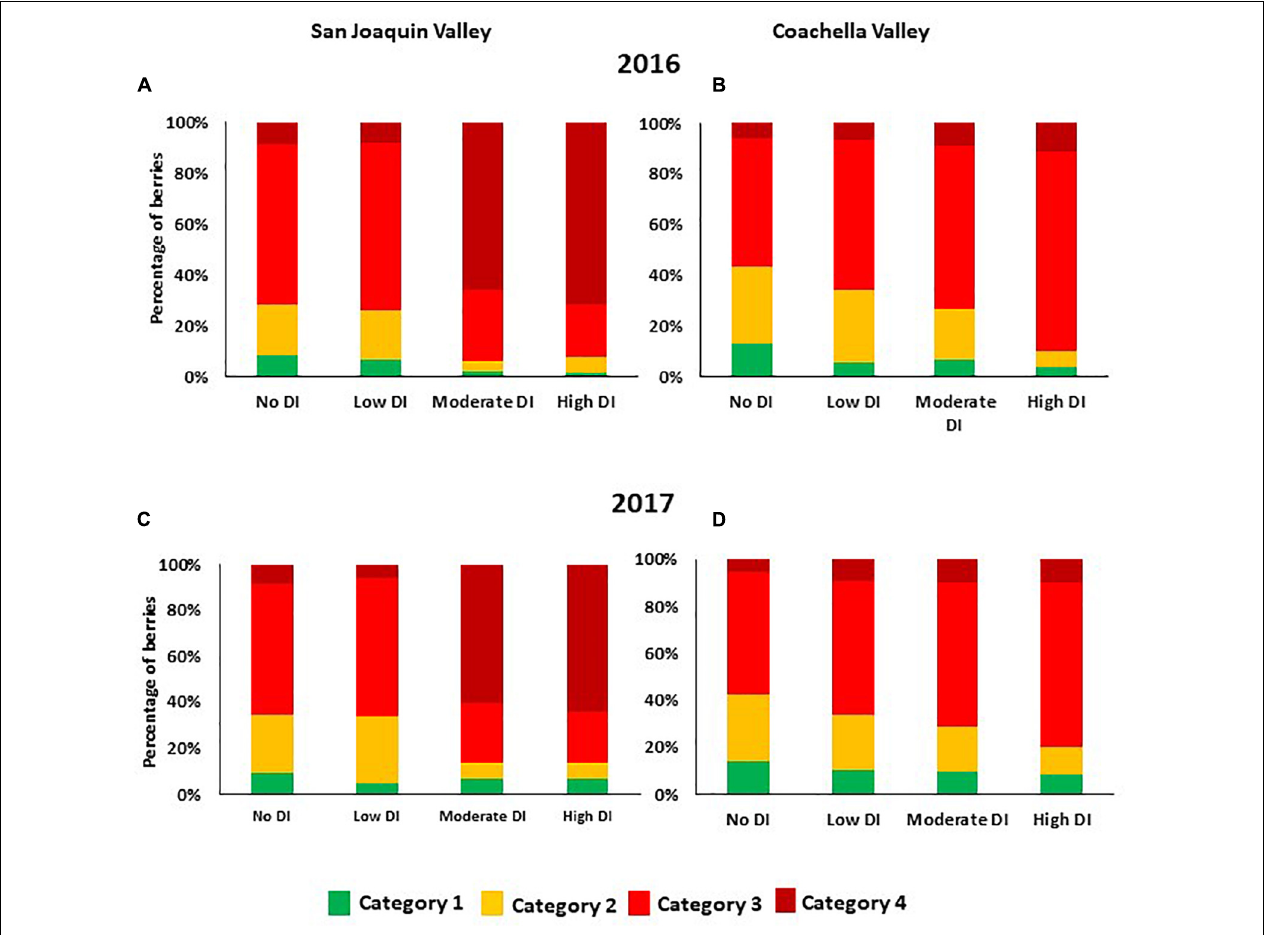
FIGURE 2 | Percentage of berries that fall within the different color categories as affected by deficit irrigation treatments in the 2016 and 2017 seasons in San Joaquin Valley (A,C) , and Coachella Valley (B,D) . Data represent the average segregation of 200 berries collected from each treatment at harvest time. The different color categories are: 1 = 25% red color; 2 = 50% red color; 3 = 75% color (bright red colored berries with green shoulders); 4 = 100% color (dark red colored berries with no green